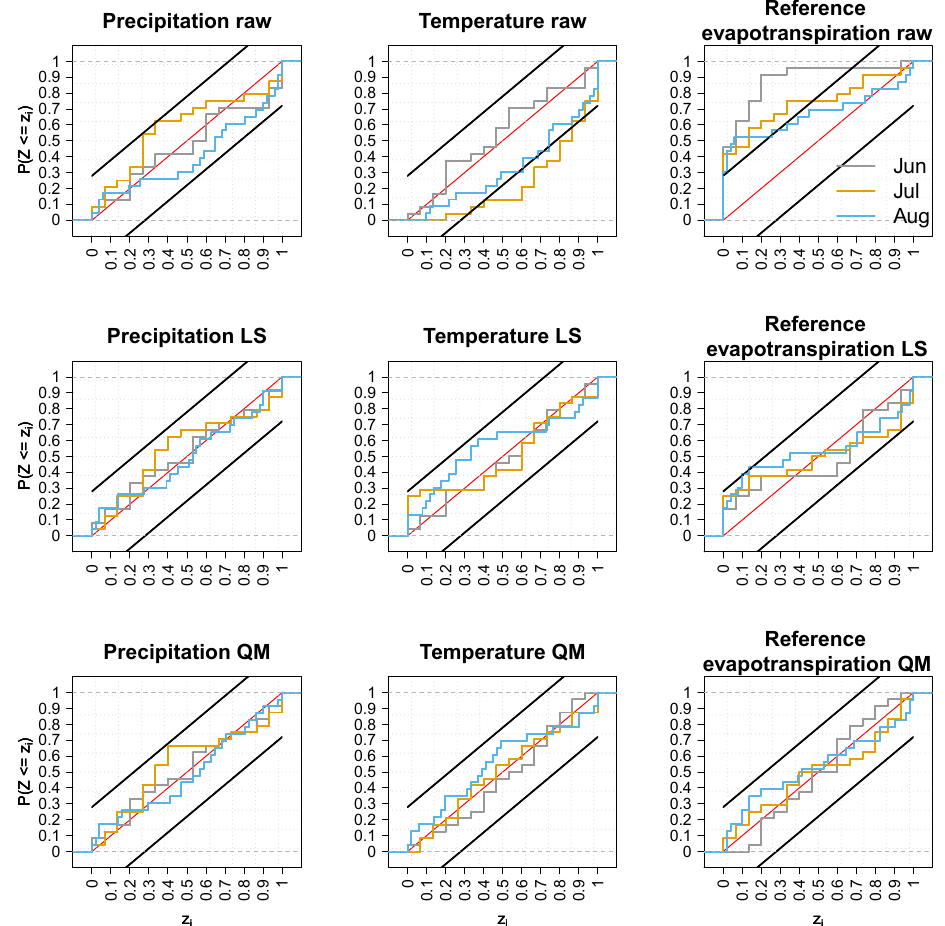
Figure 7. PIT diagrams of summer P , T and E T0 for the raw and post-processed forecasts for a lead time of 1 month for one grid point located in western Denmark.